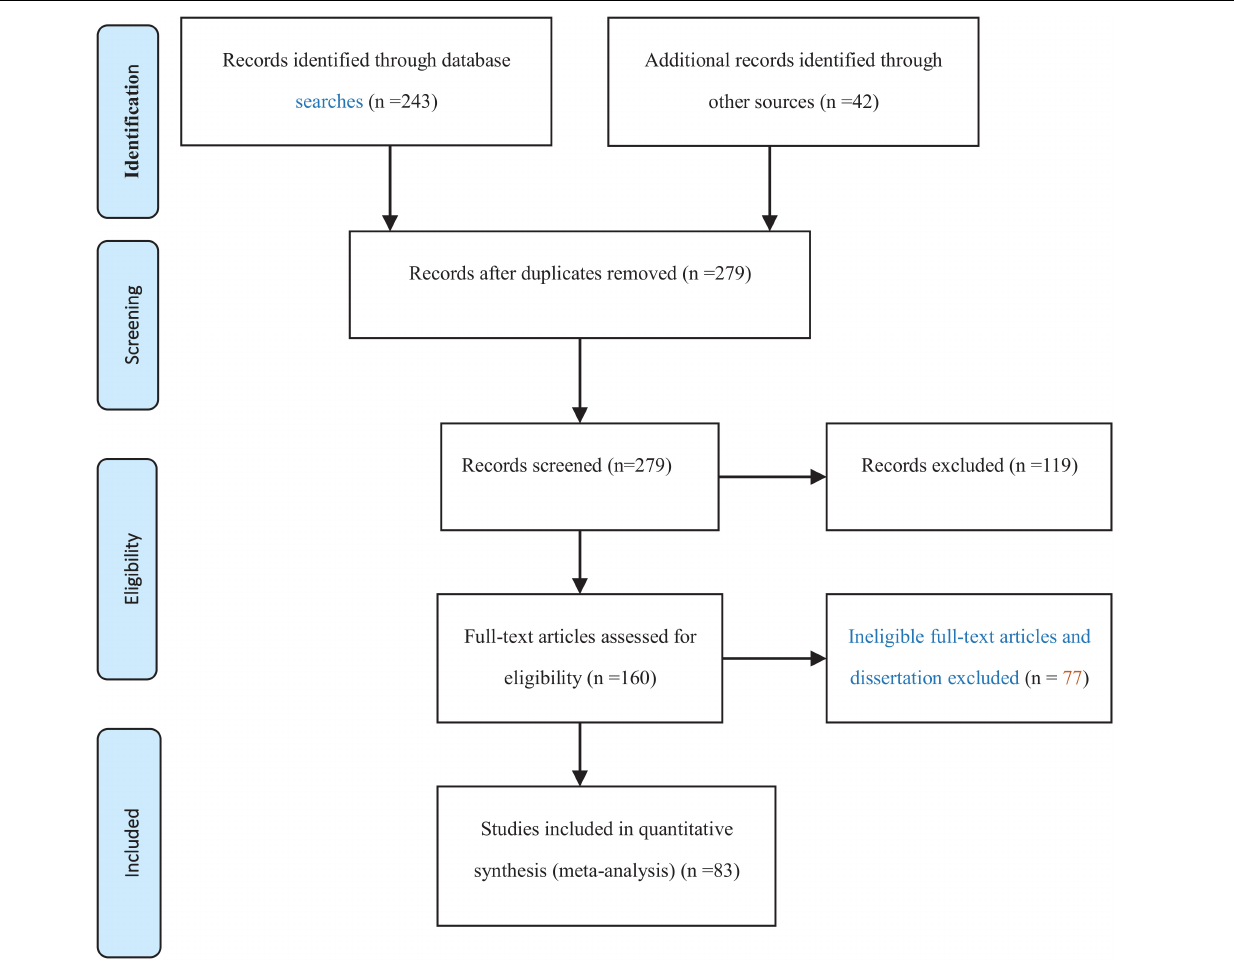
FIGURE 1 | PRISMA 2009 flow